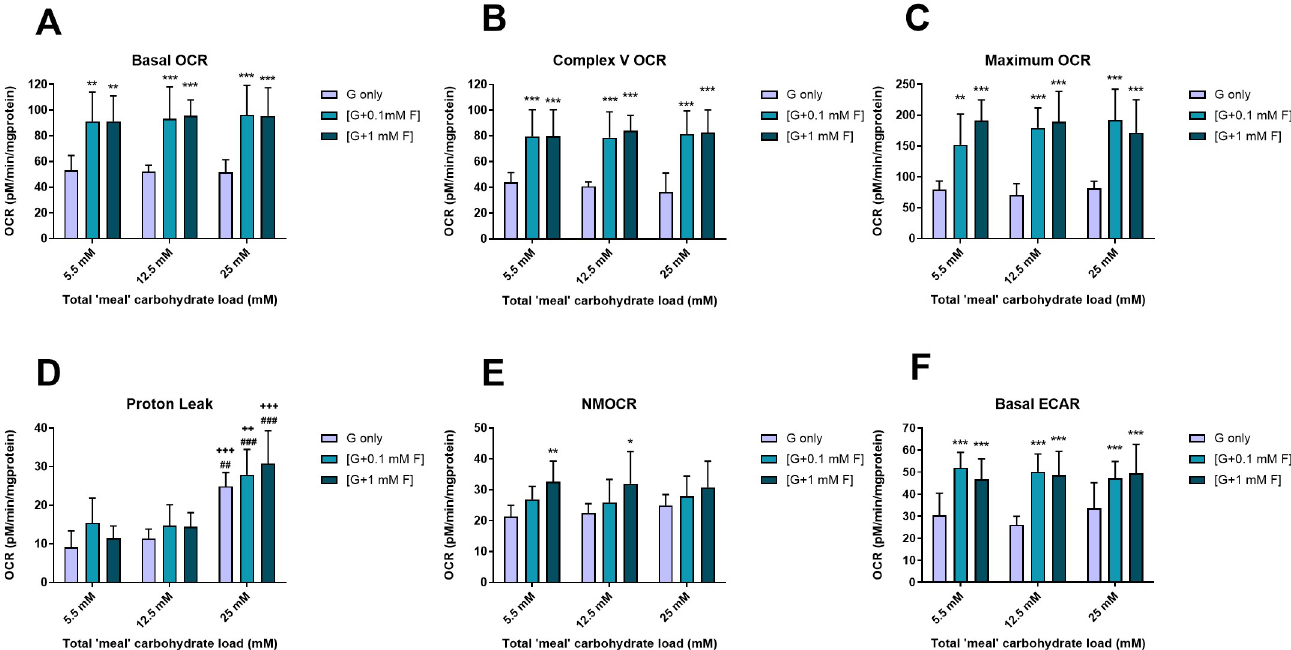
Fig 3. Cellular bioenergetics. Effect of intermittent glucose (G only)/glucose+fructose (G+0.1F, G+1F) exposure on cellular bioenergetics, described by (A) basal OCR, (B) complex V OCR, (C) maximal respiration, (D) proton leak, (E) NMOCR and (F) ECAR. Data are shown as mean ± SD for n = 6–8 separate experiments. Means are compared using 2-factor ANOVA with Bonferroni post-test. ��� P < 0.001; �� P < 0.01 for fructose-treated cells compared to glucose only treated cells with the same carbohydrate load. For proton leak, there was a significant impact of carbohydrate load (P < 0.001) and of fructose (main effect, P < 0.05). For D only: ++ + P < 0.001 and ++ P < 0.01 v equivalent bar at 5.5 mM load; ### P < 0.001 and ## P < 0.01 v equivalent bar at 12.5 mM load.